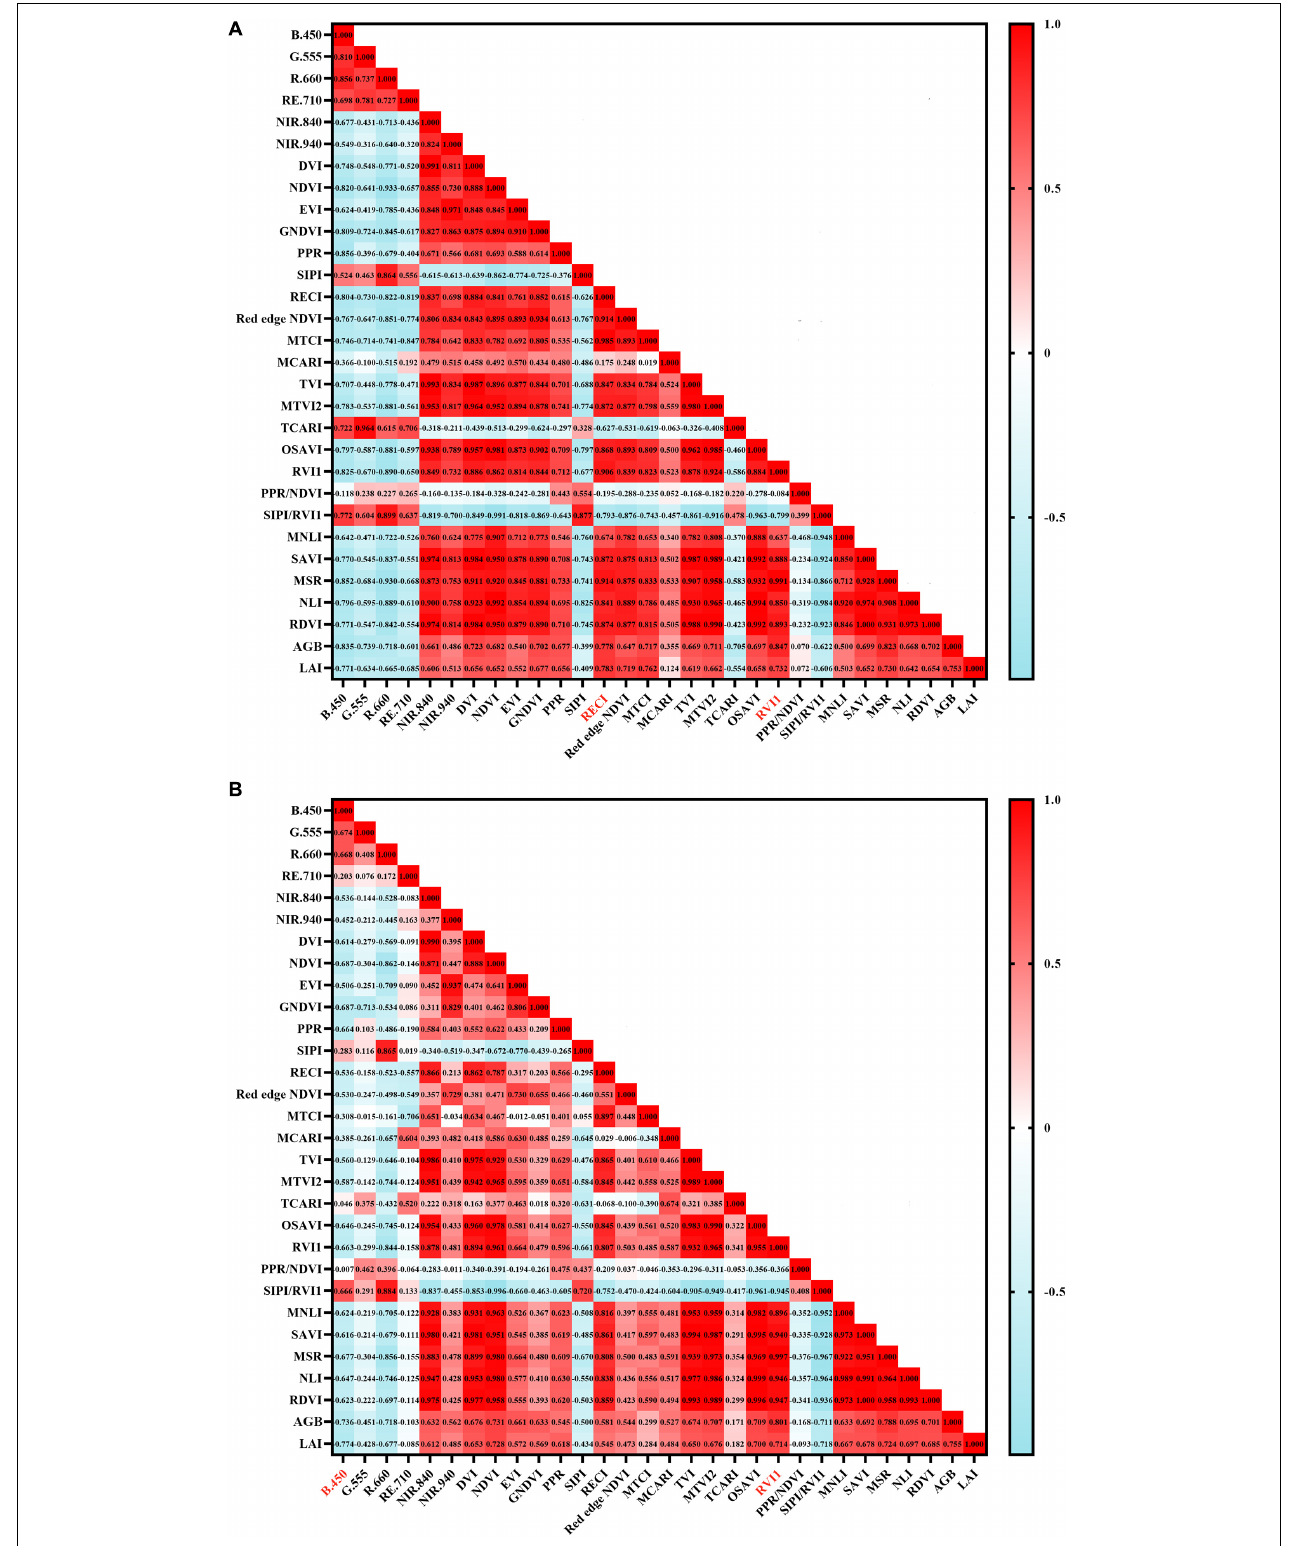
FIGURE 3 | Correlation coefficients between spectral parameters and growth parameters (AGB and LAI) of intercropped crops. (A) AGB and LAI of red bean; (B) AGB and LAI of mung bean.